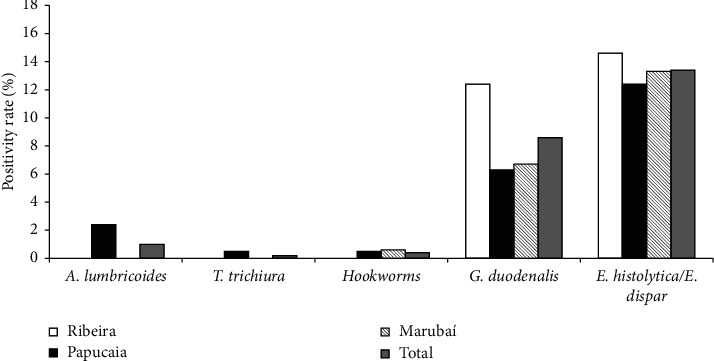
Prevalence rates of infections by different intestinal parasites in children aged 0–14 years in three communities of Cachoeiras de Macacu, Rio de Janeiro, 2018.